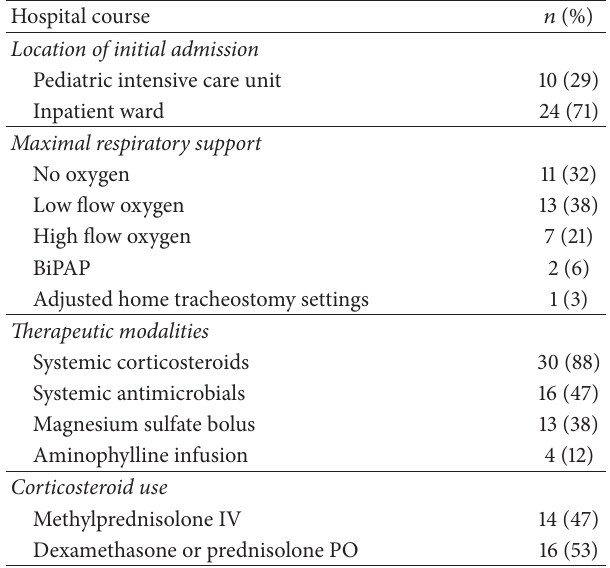
Table 3: Hospital course of pediatric inpatients with